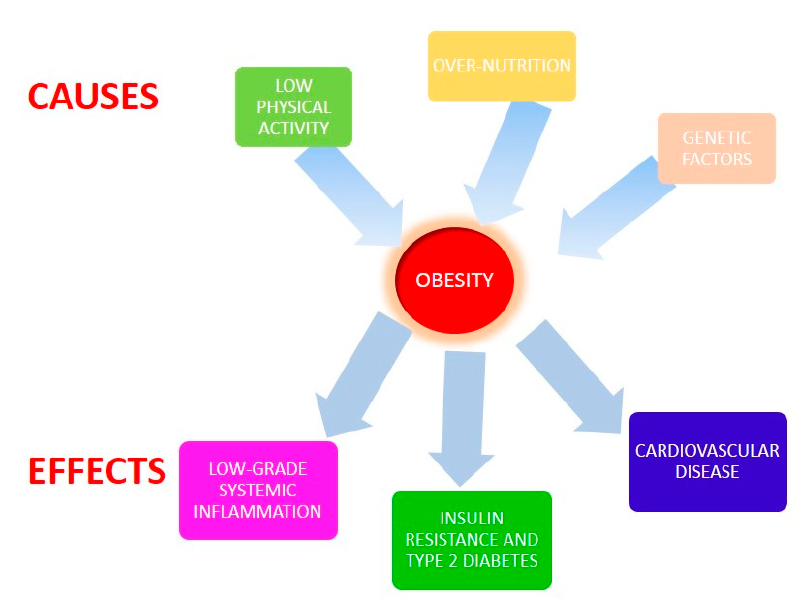
Figure 1. Causes and effects of obesity.